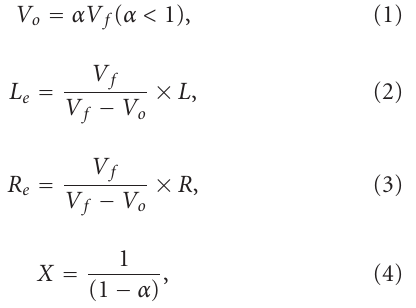
Figure 6. The horizontal axis represents the velocity ratio of the liner slider α and the vertical axis represents the di ff erences of the PSE of perceived length from the original length. Averages of perceived lengths across all participants and their standard errors are shown. Dotted lines show theoretical values calculated from